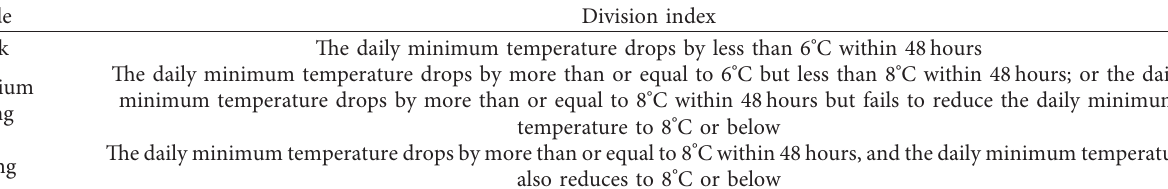
Table 1: Classification of stational ITR in China.